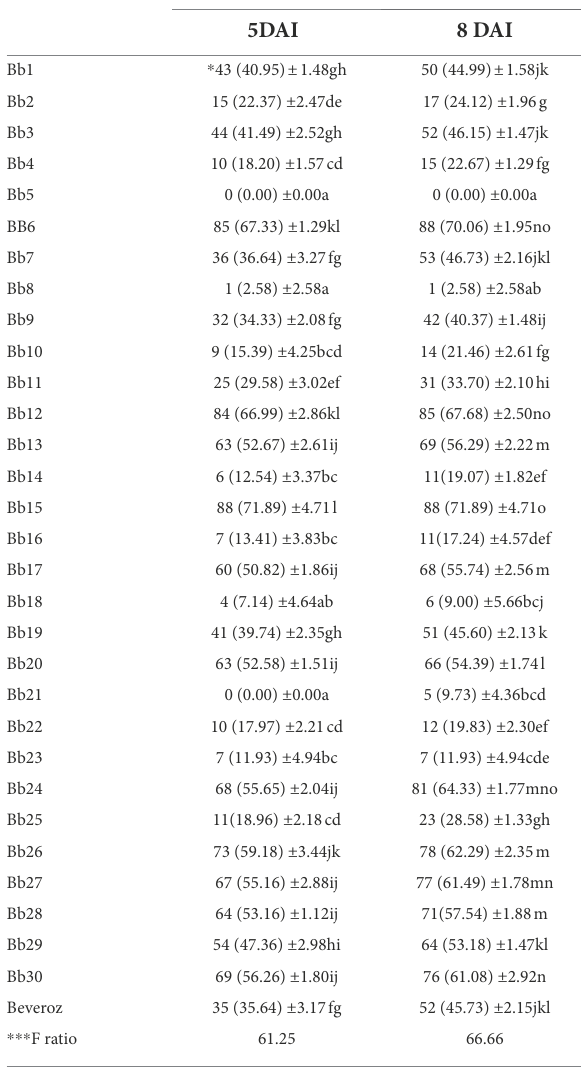
TABLE 3 Mycosis of T. truncatus infected with B. bassiana isolates. Isolates